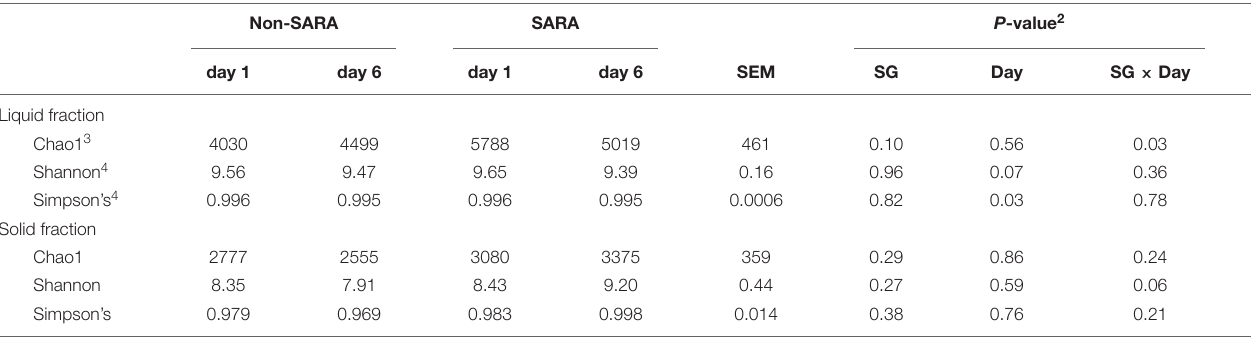
TABLE 1 | Effect of SARA induction on alpha-diversity in the liquid and solid fraction of the ruminal microbiome. 1